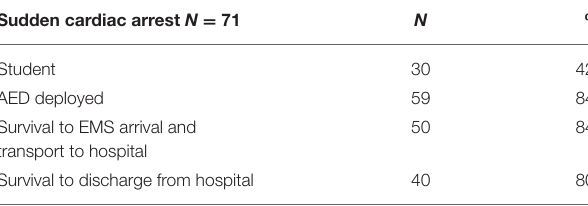
TABLE 1 | Baseline characteristics. TABLE 2 | Sudden cardiac arrest (SCA) events and AED utilization.